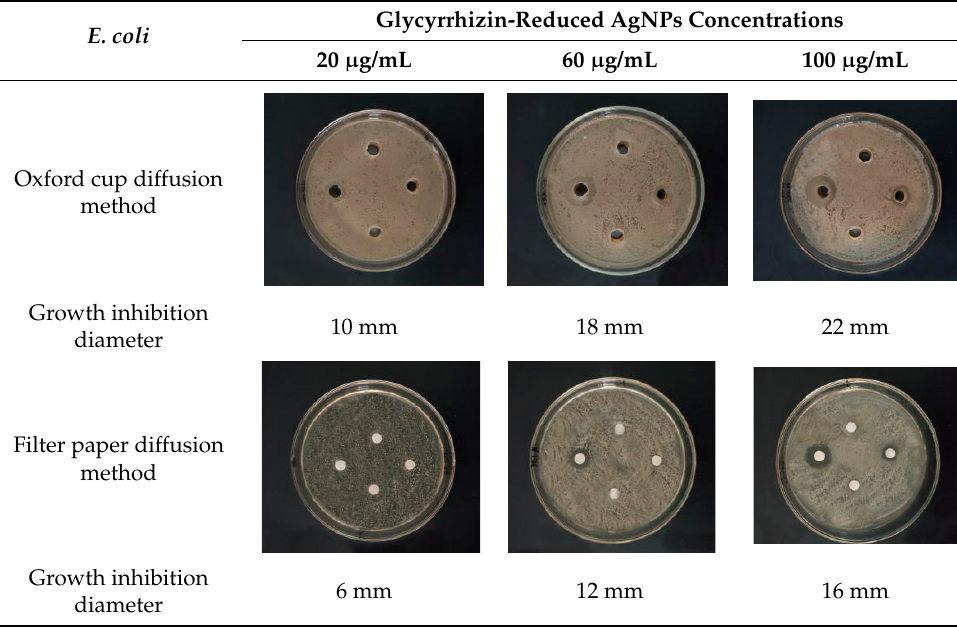
Figure 7. ( a ) UV ‒ Vis spectra of sodium citrate-reduced AgNPs, ( b ) TEM image of the sodium citrate- reduced AgNPs.